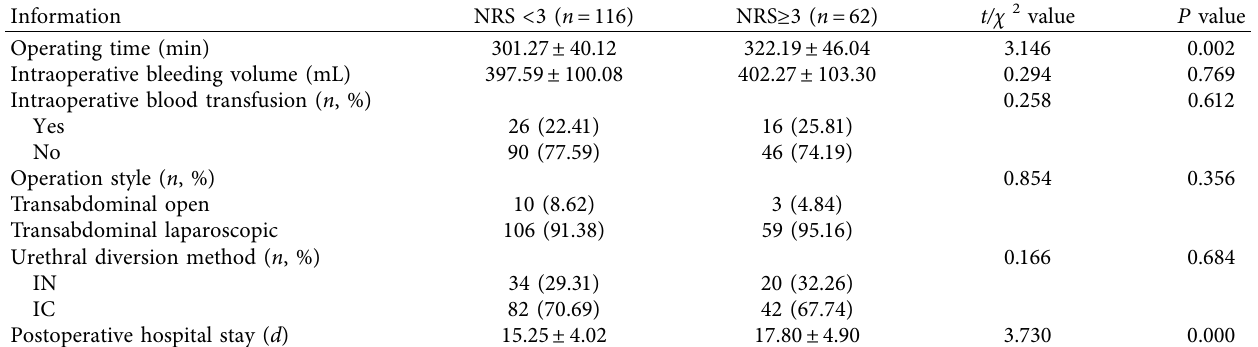
Table 3: Comparison of surgical